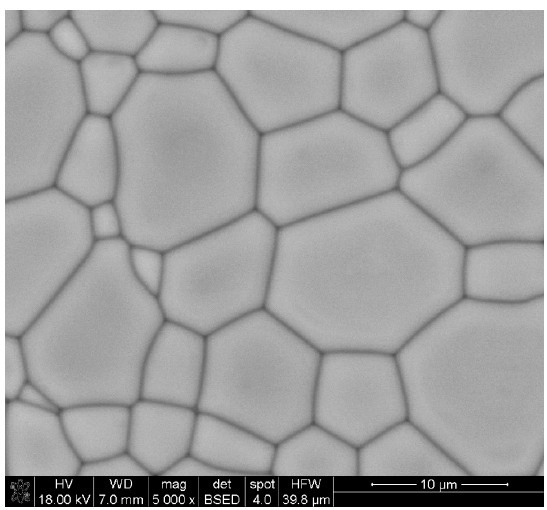
Figure 4. SEM micrographs of materials sintered at 1400 °C: ( A )—Method A, ( B )—Method B, ( C )—Method C, ( D )—Method D.